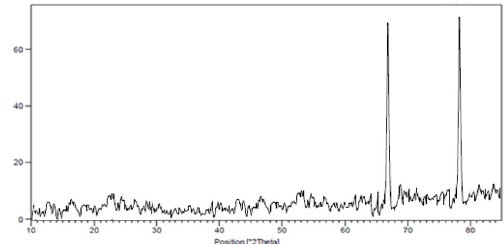
Fig. 2. XRD patterns of Au Nanoparticle. (sample